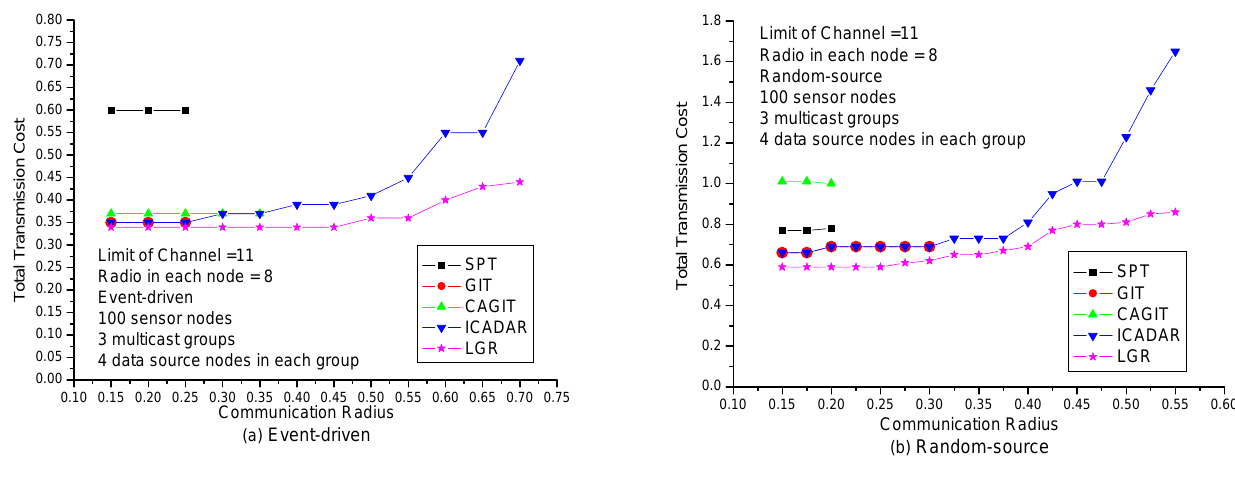
Figure 11. Performance comparison with respect to communication radius.